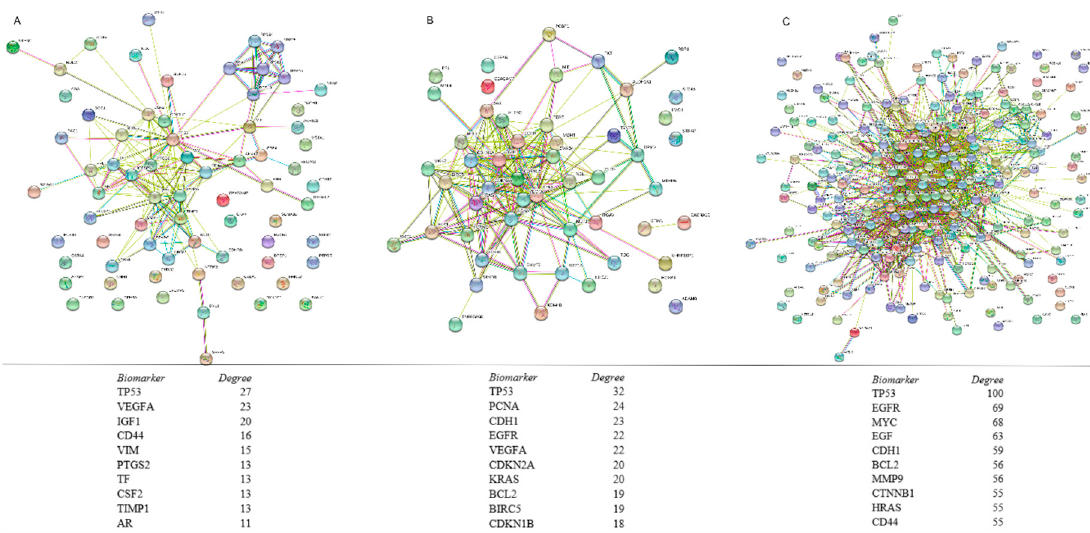
Figure 2. PPI networks of CRC protein biomarkers in diagnosis, therapy and prognosis. Distributions of protein biomarkers in diagnosis ( A ), therapy ( B ) and prognosis ( C ) of CRC are displayed. Top 10 most frequent protein biomarkers in related to the diagnosis, therapy and prognosis of the CRC are listed.